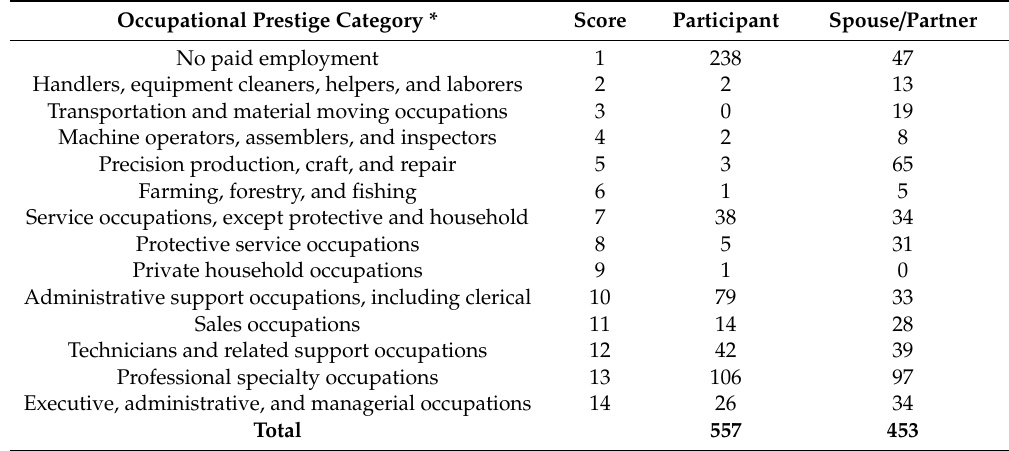
Table A1. Occupational Prestige Categories